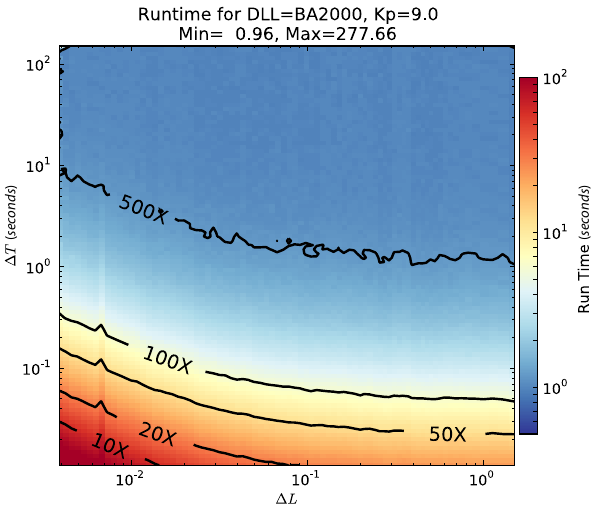
Fig. 11. Run speed benchmark for all 8000 simulations performed using BA2000 D LL ( Kp = 9 ) . The color map shows raw simulation completion time (seconds) while black contour lines show the ratio of simulation time to CPU time. For example, for a total simulation time of 600s and a CPU run time of 6s (near-white on the color scale), the code simulates the radiation belts 100 times faster than real time and has a simulation-to-CPU time ratio (black contour lines) of